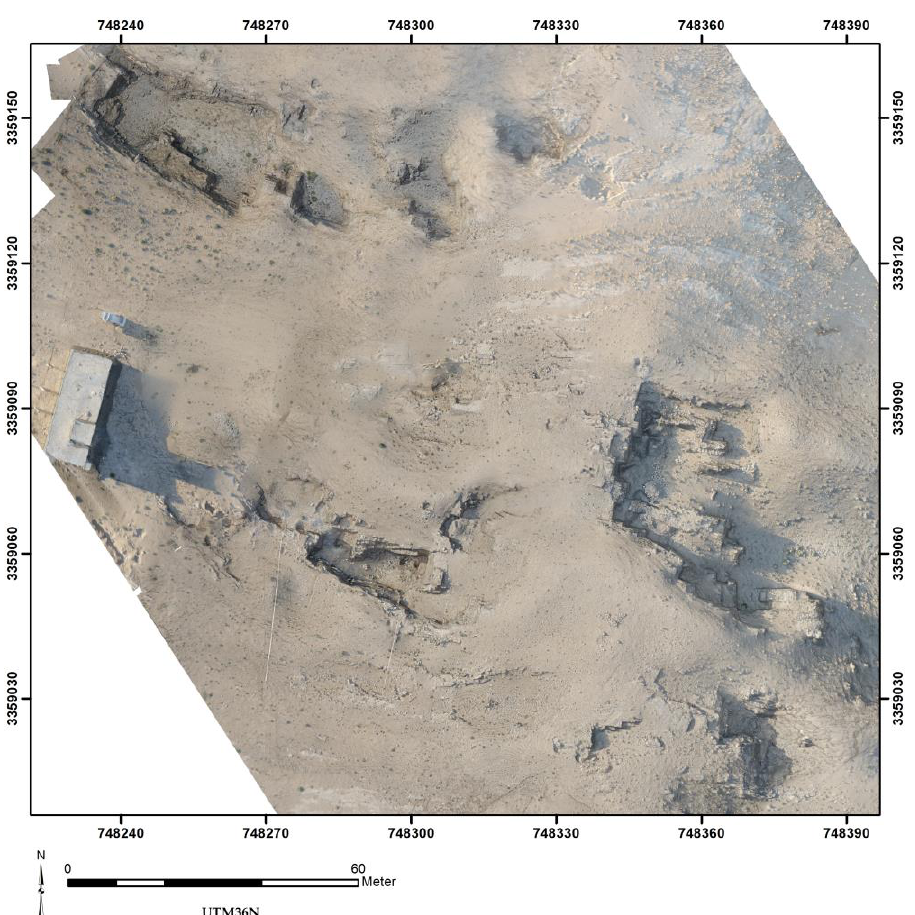
Figure 8. Georeferenced orthophoto of a part of the quarries as created with the surface model and imagery from the kite.